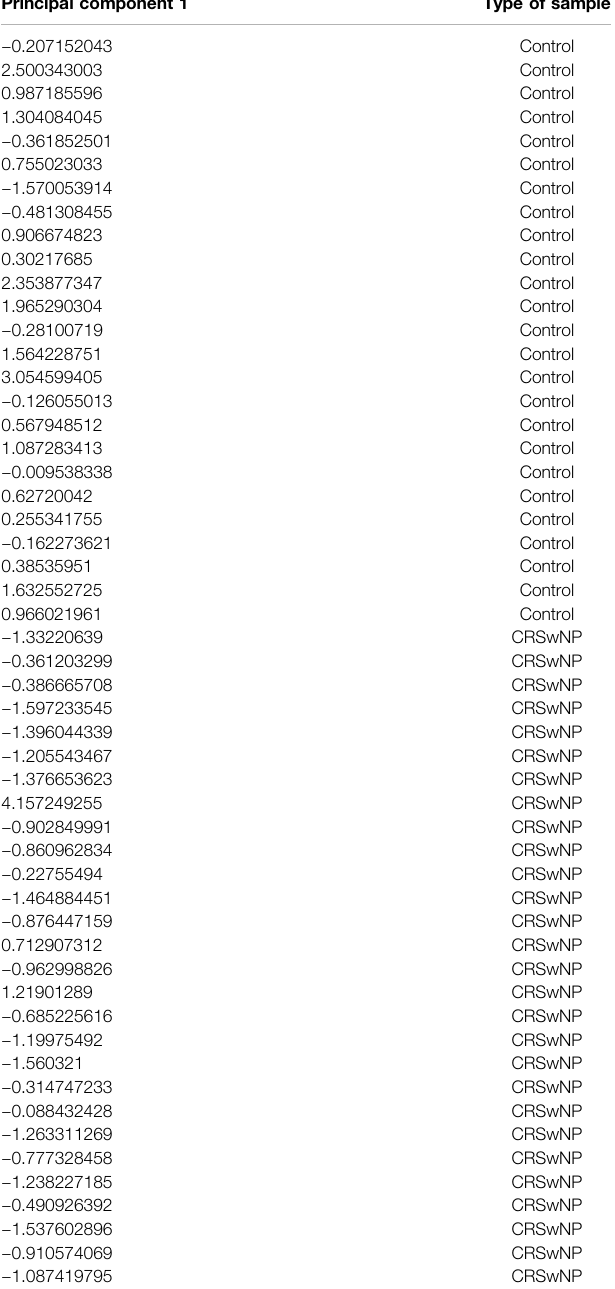
TABLE 2 | The data of principal component 1 by PCA with combinations of hsa- circ-0031593, hsa-circ-0031594, hsa-miR-132-3p, hsa-miR-145-5p, hsa- miR-146a-5p, and